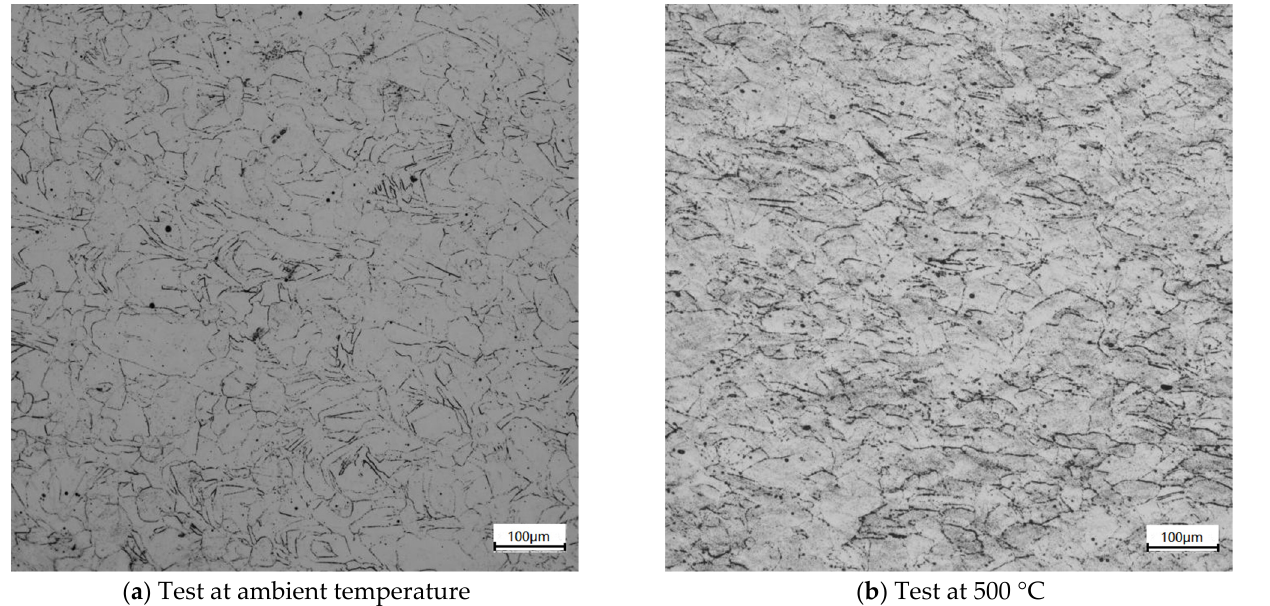
Figure 15. Microscopy observations of tested specimens.